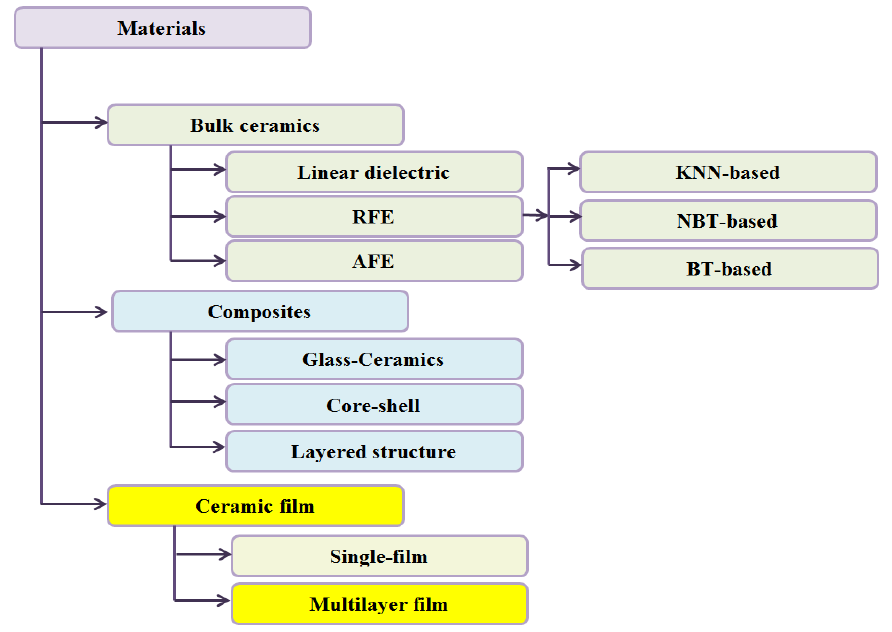
Figure 3. An overview of the different dielectric materials for different types of ceramic